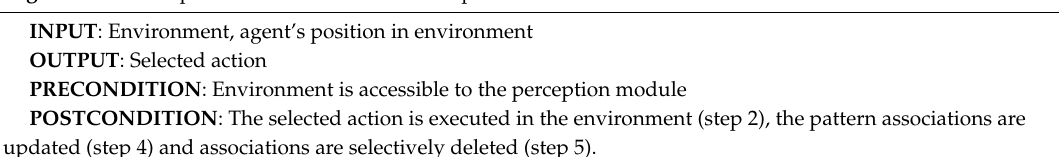
Algorithm 1. Perception-action-value association